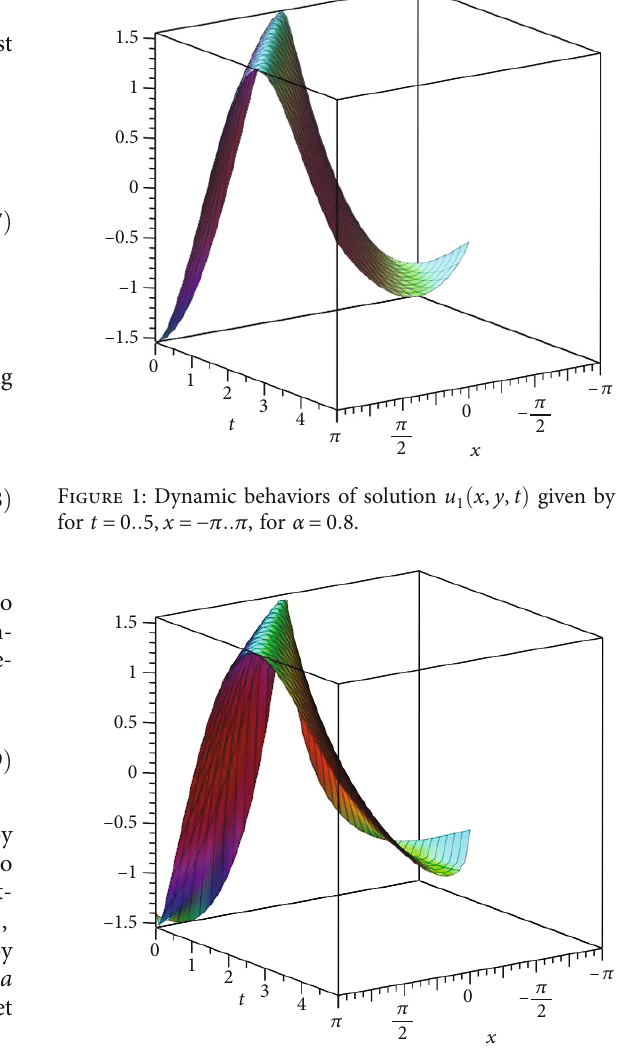
ð x , y , t Þ given by 1